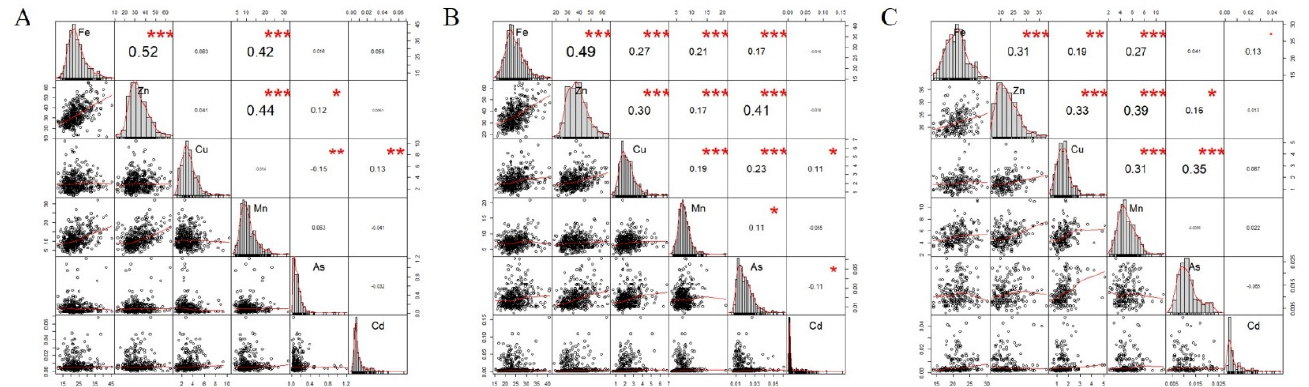
Figure 2. Frequency distributions and phenotypic correlations of Fe, Zn, Cu, Mn, As and Cd. ( A ) Hainan; ( B ) Dongyang; ( C ) Xinxiang. The Performance Analytics package in R software was used to calculate the correlation of traits in each location. Asterisk represents a significant difference. * p < 0.05, ** p < 0.01, *** p < 0.001 (Student’s t -test).